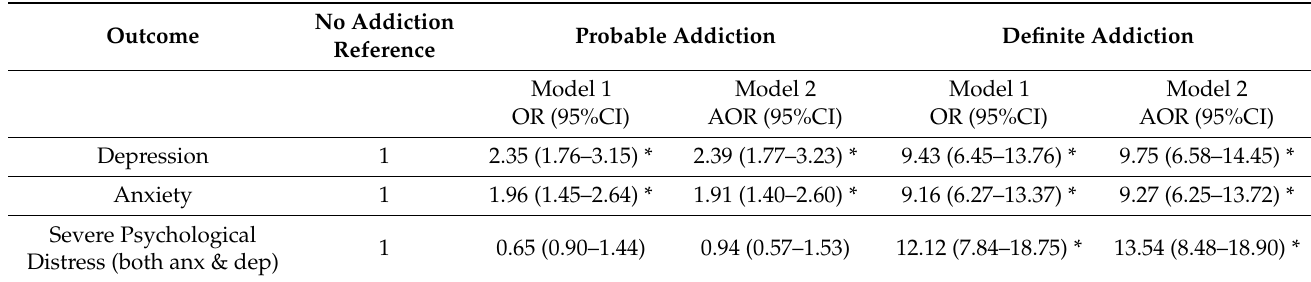
Table 3. Regression Analyses to Predict Psychological Distress Based on Internet Addiction